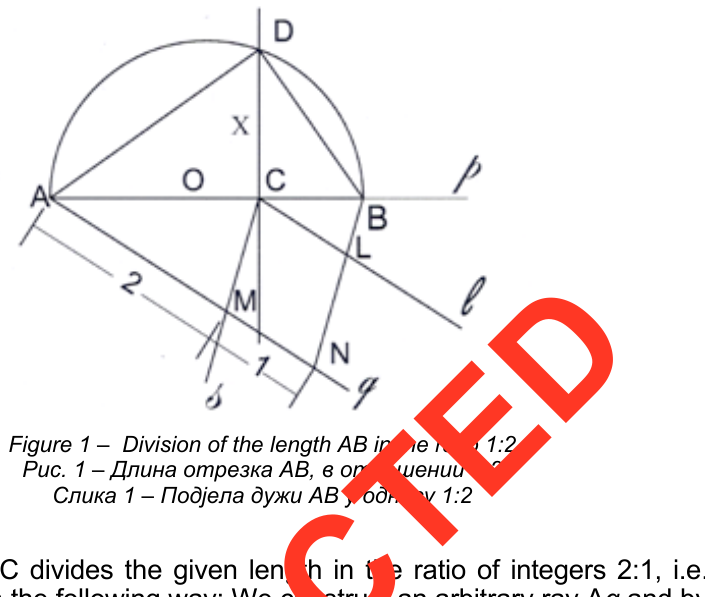
Figure 1 – Division of the length AB in the ratio 1:2 Рис . 1 – Длина отрезка АВ , в отношении 1:2 Слика 1 – Подјела дужи AB у односу